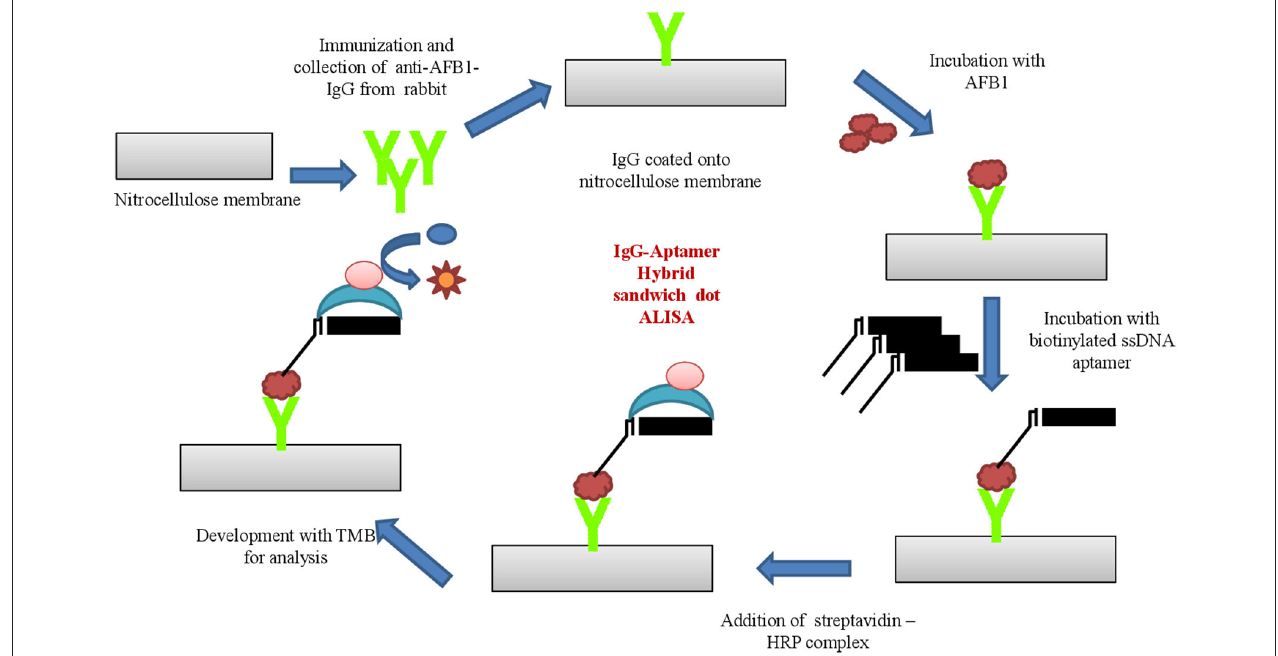
FIGURE 5 | Schematic illustration of developed Aptamer-antibody sandwich immunoassay.